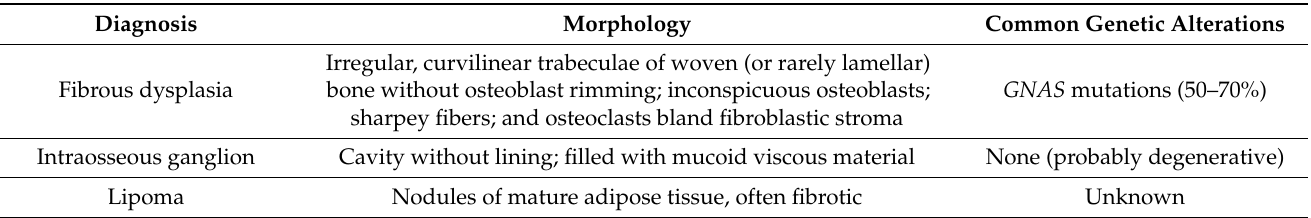
Table 14. Differential diagnoses of simple (unicameral) bone